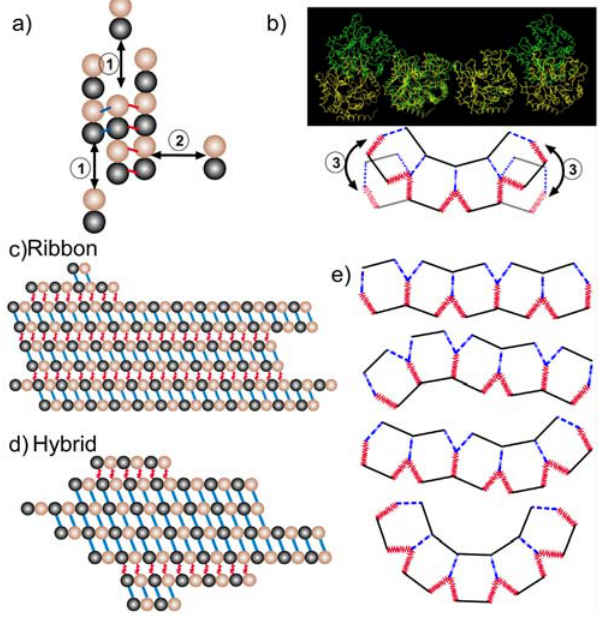
Figure 2. Schematic illustration of the basic concepts in the proposed model of tubulin self-assembly. (a) Three types of reactions are being modeled: longitudinal (1) and lateral (2) association/ disassociation, and (b) the switch between the tube and sheet types of bond (3). Blue lines correspond to the tube bond and red lines to the sheet bond. The EM-based structures at the top of (b) show the difference between two lateral bond types [9]. (c) A typical ribbon structure with alternating lateral bonds. (d) A typical hybrid structure with the two types of lateral bonds randomly distributed. (e) An end-on view of several possible 5-PF structures.